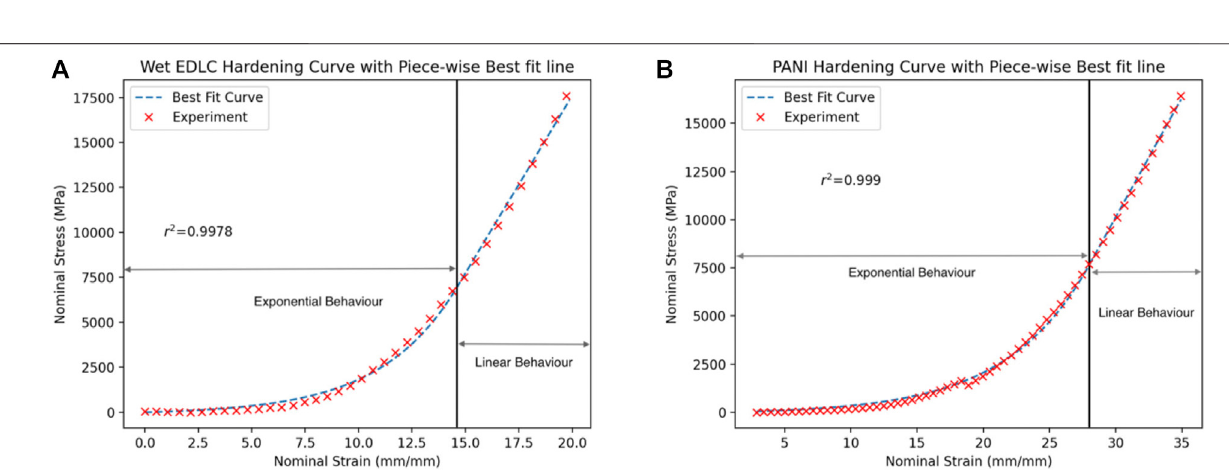
FIGURE A2 | (A) Piece-wise best fi tting curve for PANI-1, wet PANI pseudocapacitor (B) Piece-wise best fi tting curve for wet EDLC-1.